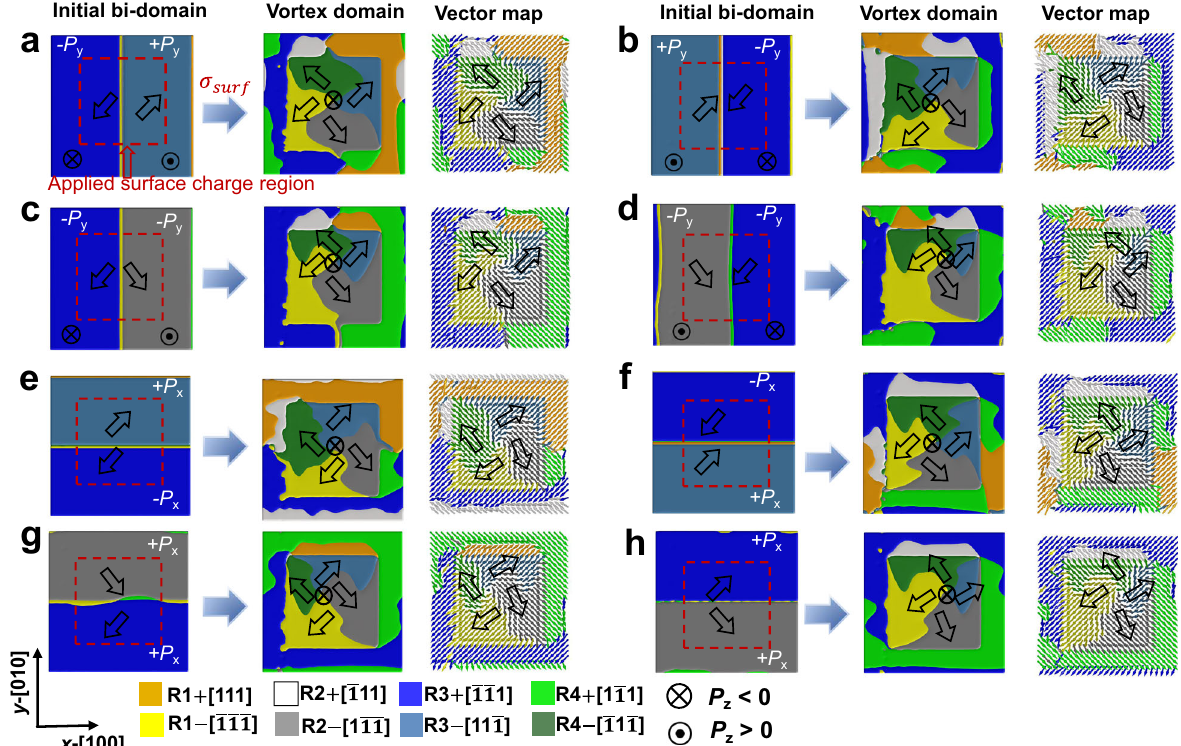
Fig. 4 The manipulation of vortex chirality by bi-domain arrangements. The bi-domain arrangements are separated by 180° and 109° DWs oriented along the y axis: a Initial R3 + |R3 − polarization arrangement and LH chiral vortex. b Initial R3 − |R3 + polarization arrangement and RH chiral vortex. c Initial R3 + |R2 − polarization arrangement and LH chiral vortex. d Initial R2 − |R3 + polarization arrangement and LH vortex. The bi-domain arrangements are separated by 180° and 109° DWs oriented along the x axis. e Initial R3 + /R3 − polarization arrangement and RH vortex. f Initial R3 − /R3 + polarization arrangement and LH vortex. g Initial R3 + /R2 − polarization arrangement and RH vortex. h Initial R2 − /R3 + polarization arrangement and LH